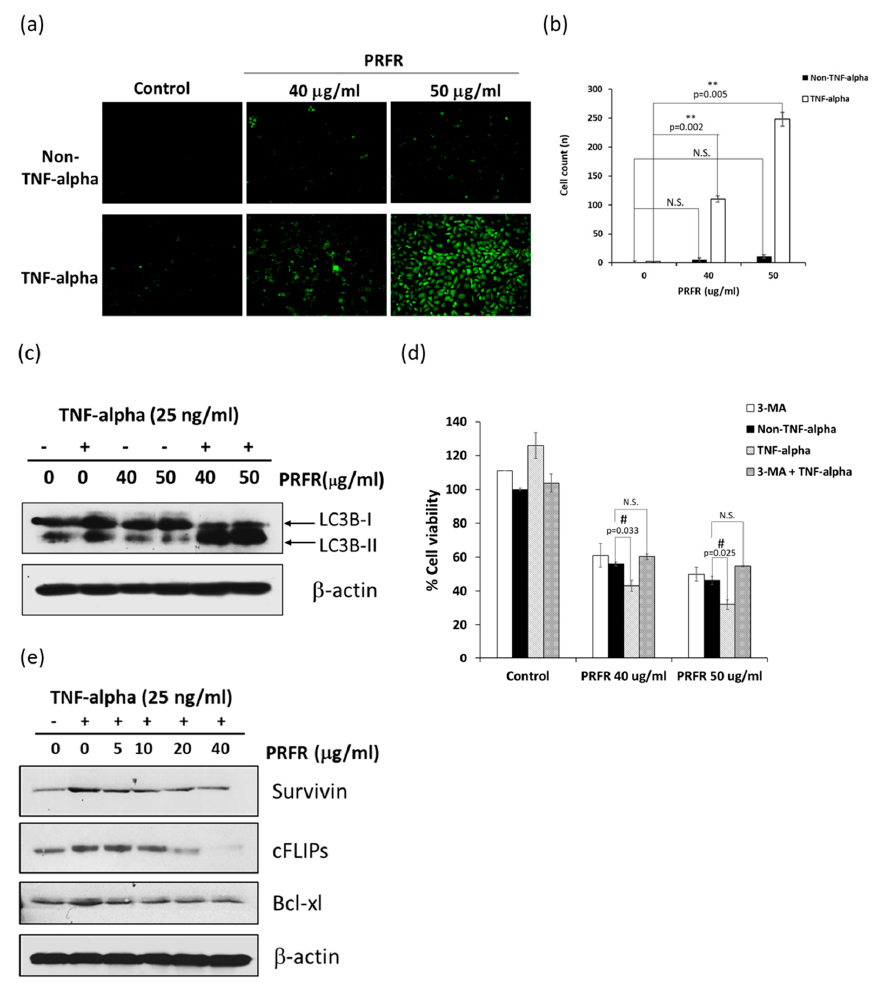
Figure 2. PRFR enhanced TNF- α -induced autophagic cell death in A549 cells. ( a , b ) A549 cells were stained with monodansylcadaverin (MDC) after being preincubated with 40 and 50 µ g / mL PRFR and